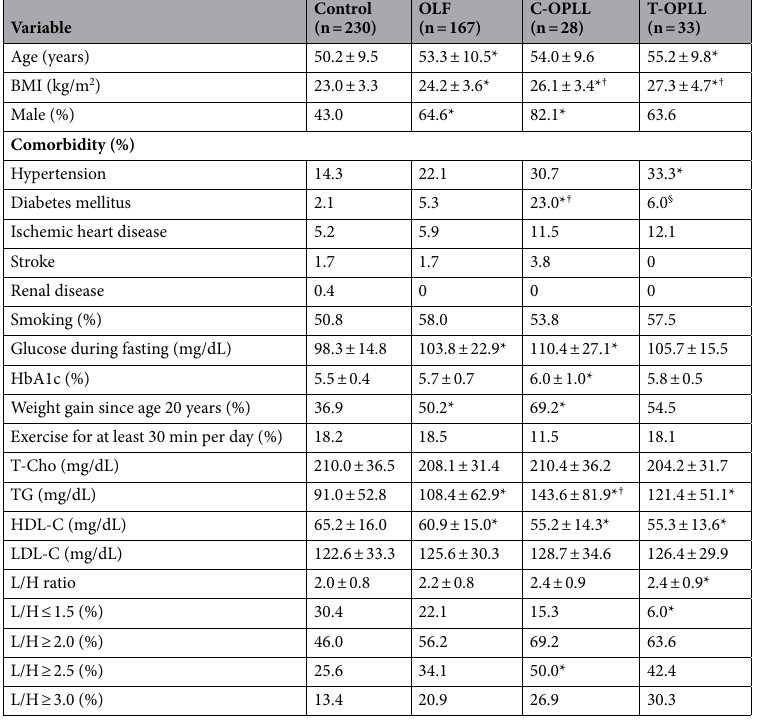
To determine the relative contribution of risk factors to ossification, we compared the standardized β-values for each type of spinal ligament ossification. For both OLF and C-OPLL, the standardized β-value for dyslipi- demia was higher than that for age, BMI, being male, the L/H ratio, and diabetes mellitus. For T-OPLL, the standardized β-value for BMI was higher than that for dyslipidemia.